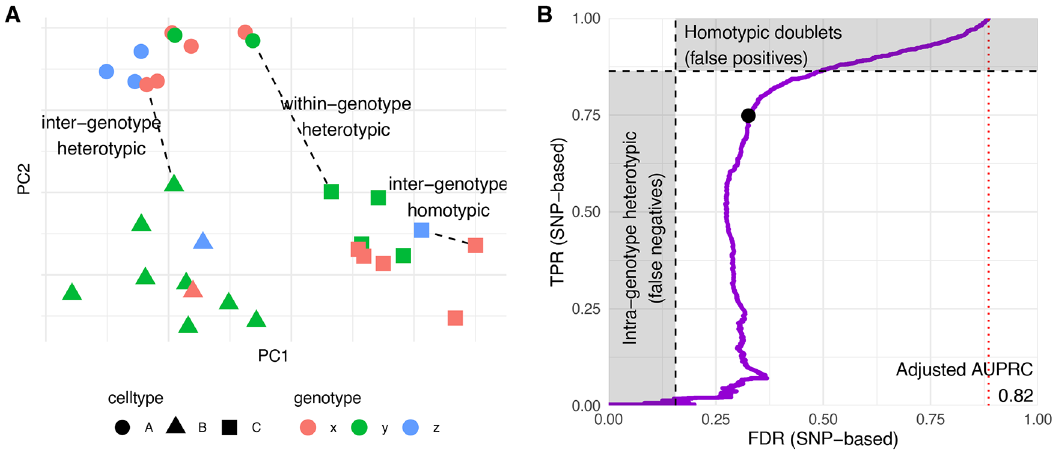
Figure 4. Doublet types and real accuracy of heterotypic doublet identification. A: Cartoon representing the different types of doublets. Within-individual heterotypic doublets will wrongly be labeled as false positives, and between-individual homotypic will be labeled as false negatives. B: Adjusted PR curve for an example sample (GSM2560248). The two shaded areas represent the expected proportion of within-individual heterotypic doublets (i.e.wronglylabeledassingletsintheannotationusedasgroundtruth)andbetween-individualhomotypicdoublets, respectively. The red dotted line indicates the random expectation, and the black dot indicates the threshold set by